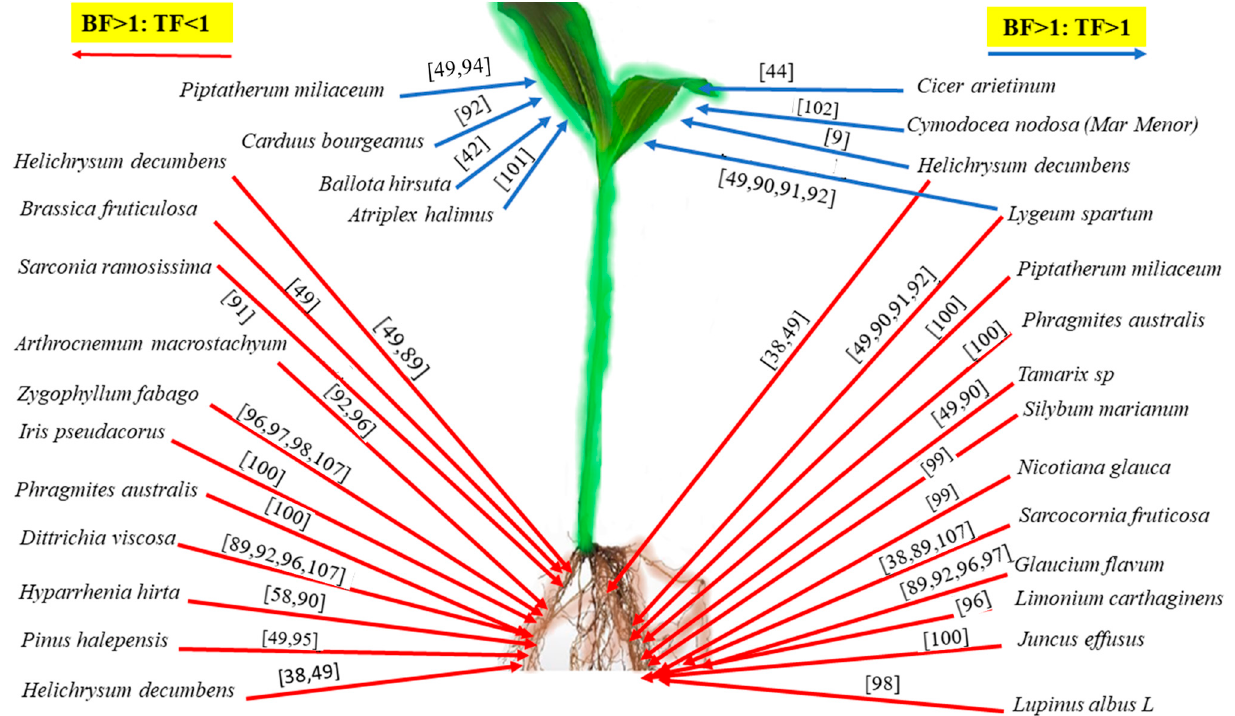
Figure 8. BF and TF of the main plant species related to the study area [9,38,42,44,49,58,87–90,92–100,107].